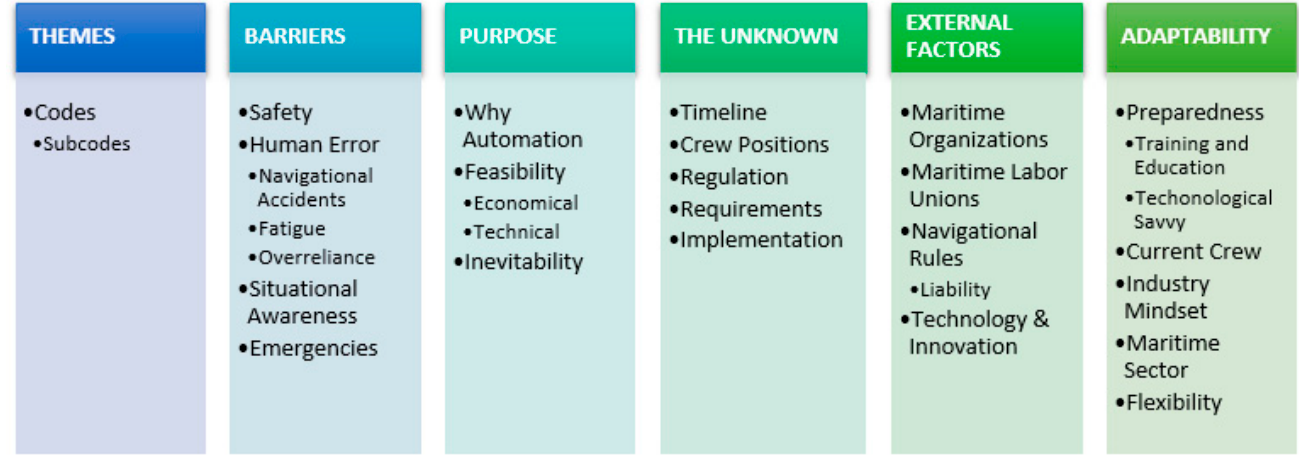
Figure 5. Thematic Analysis themes, codes, and subcodes.